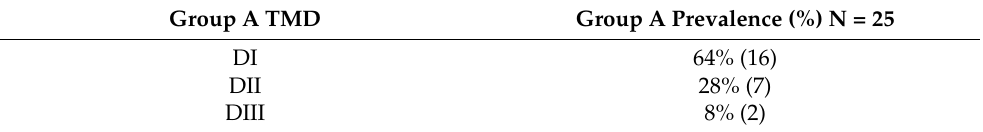
Table 3. Absolute frequency and percentage ( n (%) values) of Group A according to Helkimo index. Group A